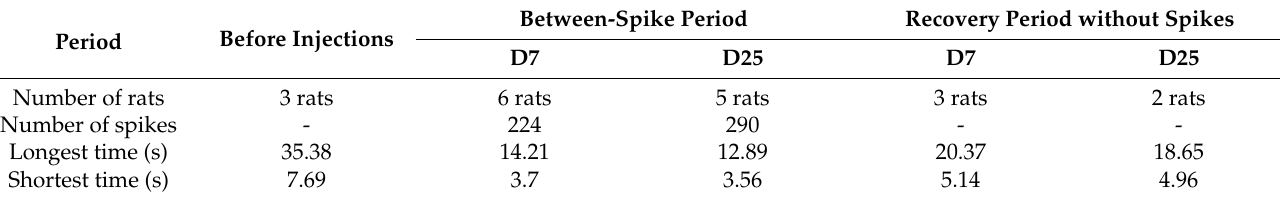
Table 1. Data information during different periods.